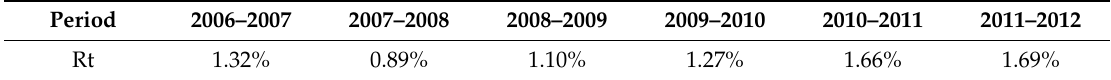
Table 3. Land use integrated dynamic degree (Rt) in Wuhan from 2006 to